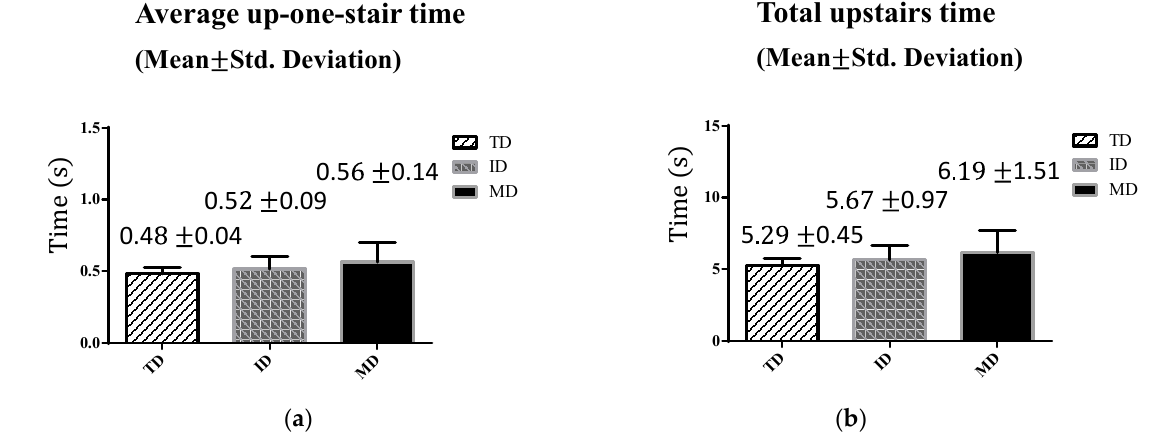
Figure 9. Upstairs walking results: ( a ) average up-one-stair time; and ( b ) total upstairs time.